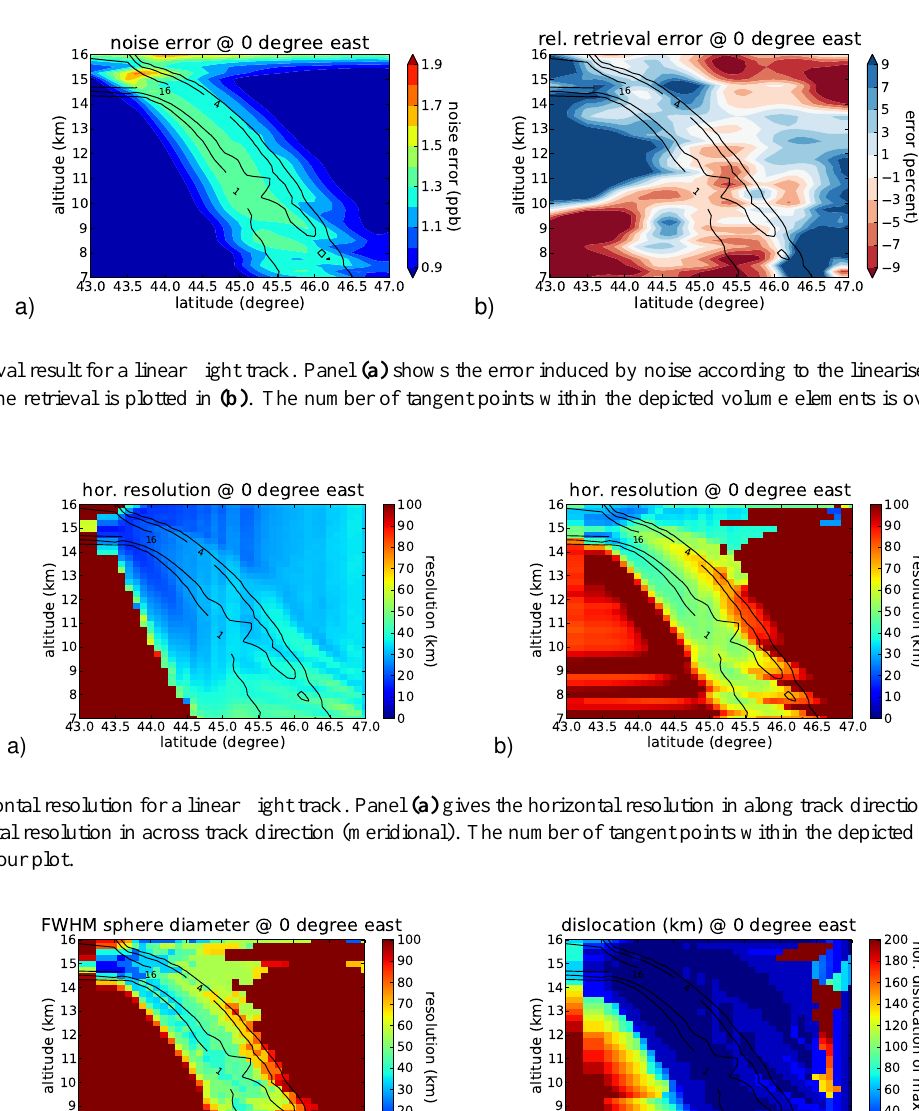
Fig. 5. The retrieval result for a linear flight track. Panel (a) shows the retrieved ozone concentrations. The relative error of the retrieval is plotted in panel (b) . The number of tangent points within the depicted volume elements is overlaid as a contour plot. volume elements is overlaid as a contour plot.